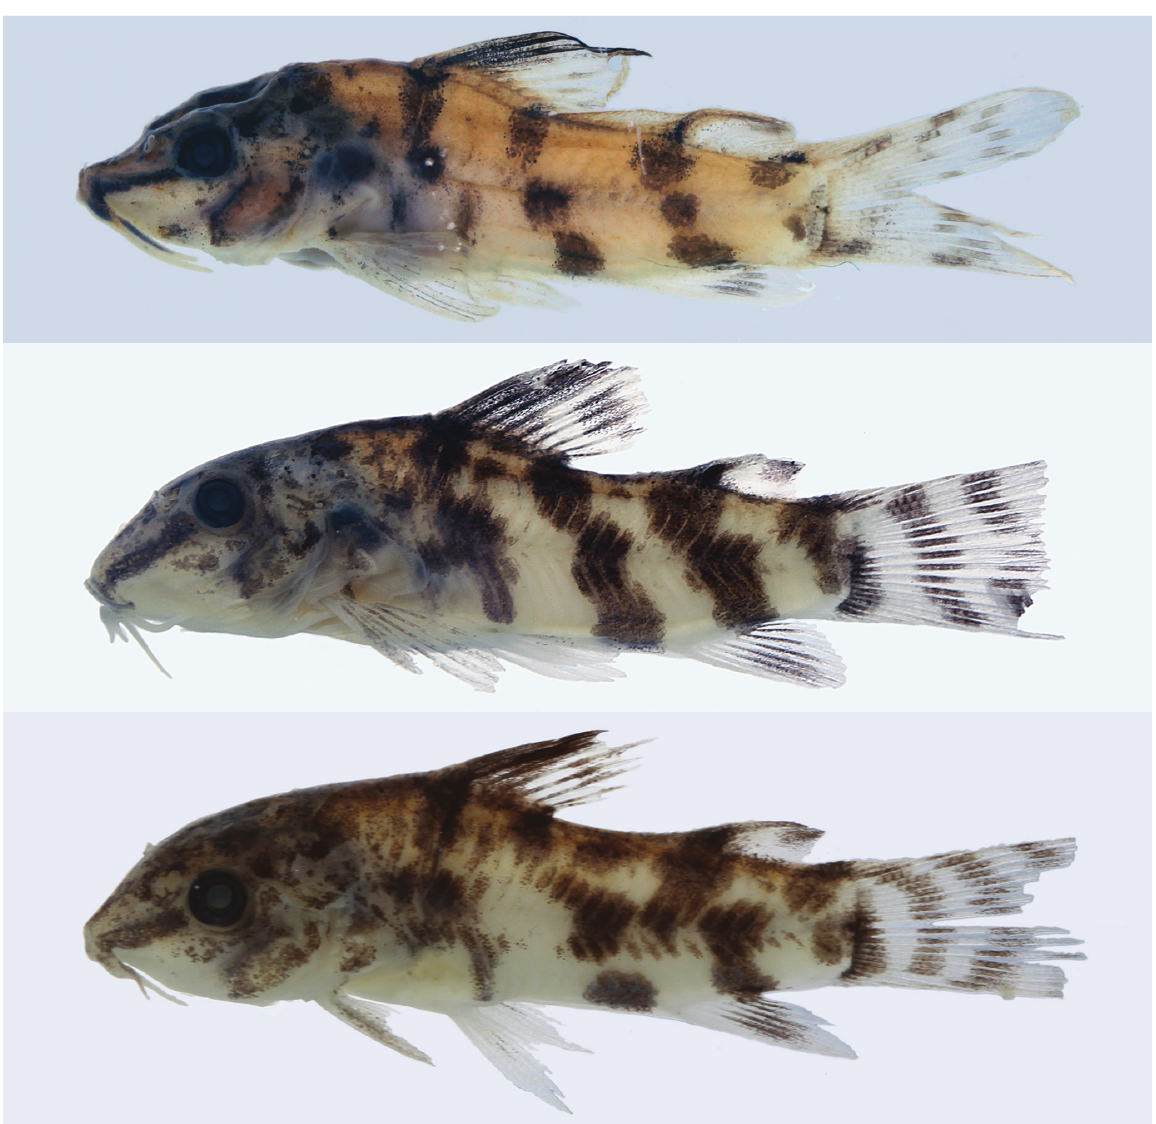
Fig. 7. Scleromystax reisi , paratypes. Changes in the color pattern during early stages of the ontogenesis. MCP 48177, 13.5 mm SL (top); MCP 48178, 18.8 mm SL (middle); UFRGS 19191, 19.4 mm SL